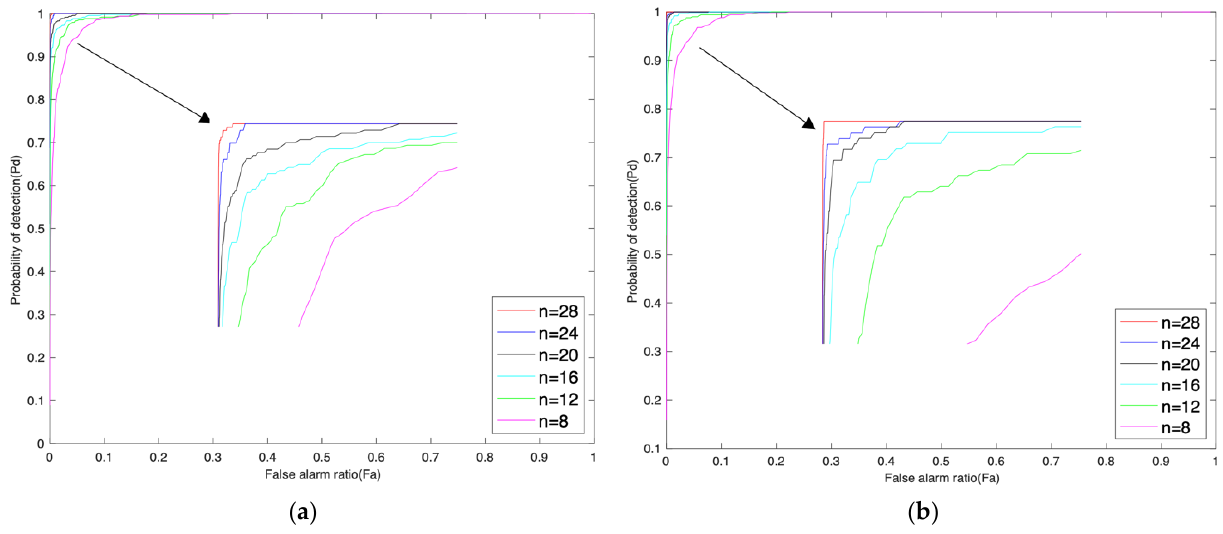
Figure 9. ROC curves of two stage MHT. 𝑛 denotes the number of used images. ( a ) ROC curves when SCR is 1.4; ( b ) ROC curves when SCR is 1.5. Table 3. 𝑃(𝐵|𝐴) when SCR is 1.4.